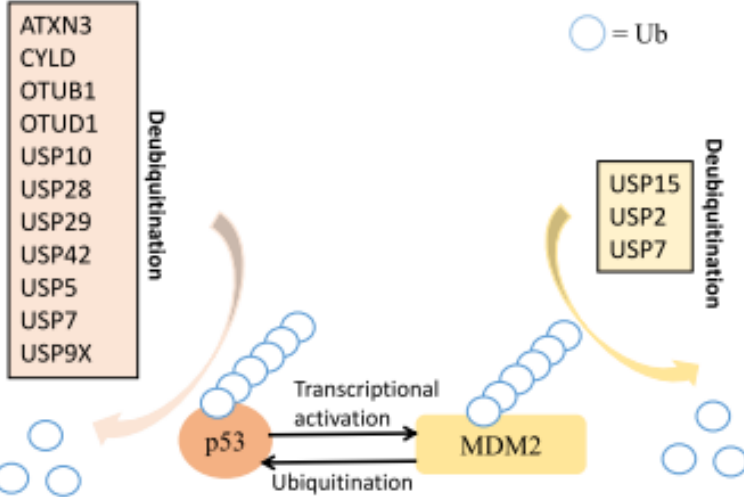
Figure 2. DUBs in MDM2-p53 pathways. Ubiquitination is found on both p53 and MDM2 molecules; various DUBs could revise that via deubiquitination to regulate the p53 pathway. DUBs’ targets on p53 are labeled in light brown; those that interact with MDM2 are labeled in light yellow. Detailed descriptions can be referred to the main text.